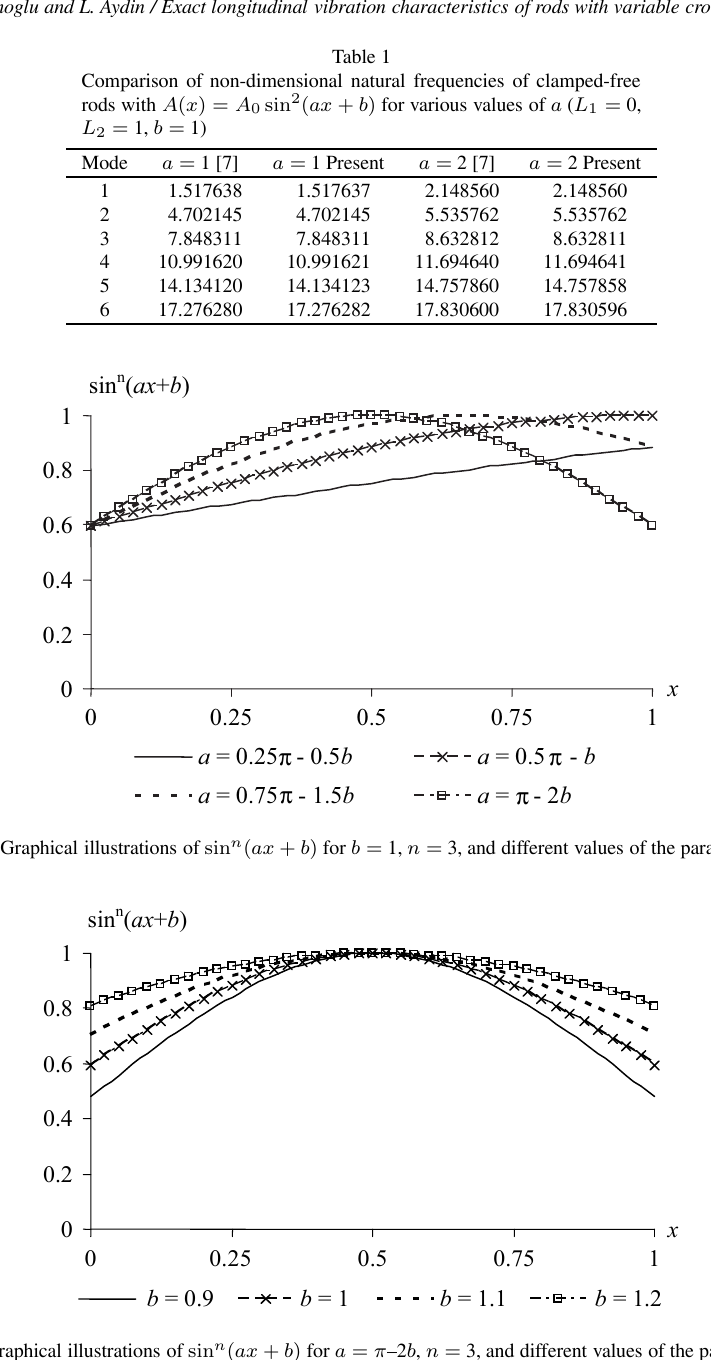
Fig. 2. Graphical illustrations of sin n ( ax + b ) for a = π –2 b , n = 3, and different values of the parameter b